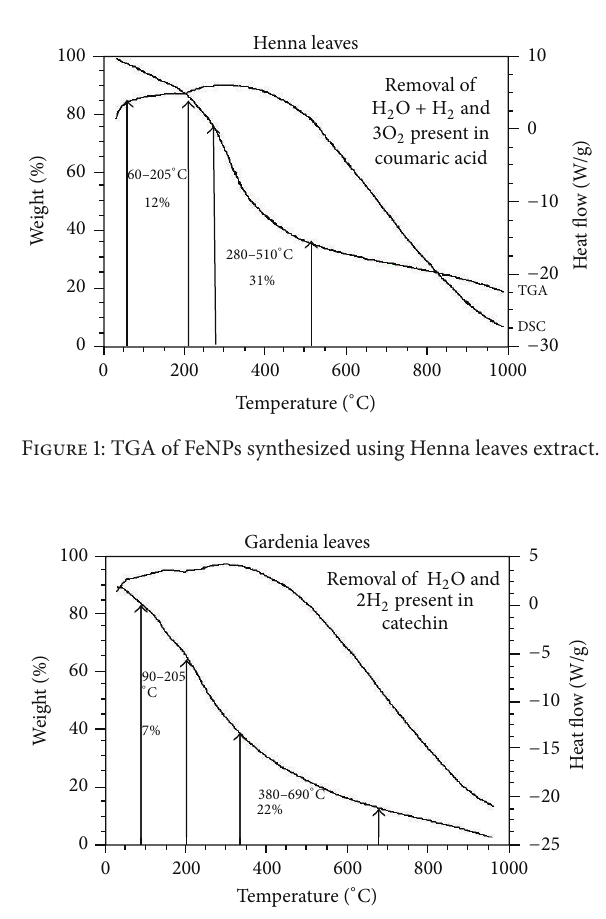
Figure 2: TGA of FeNPs synthesized using Gardenia plant extract.